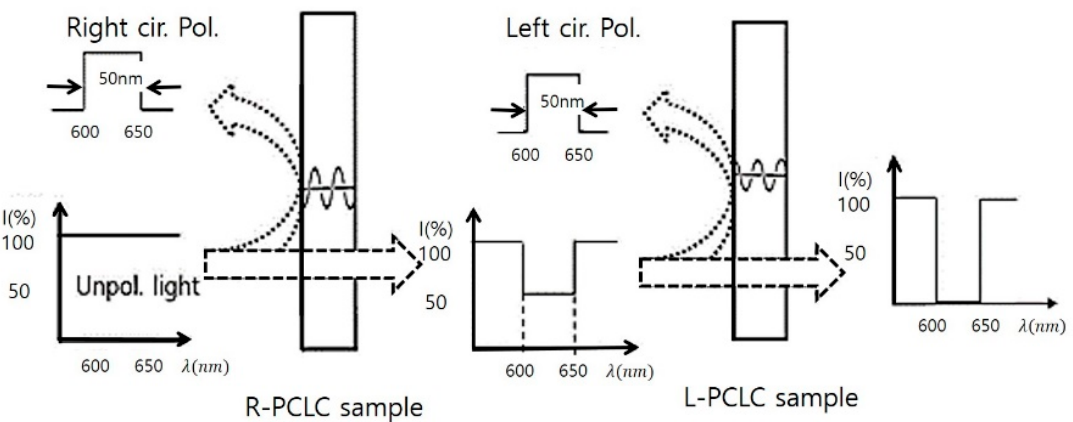
Figure 1. Principle of a circular polarizer by one R-PCLC (or L-PCLC) and a notch filter by two R- PCLCs. A notch filter works for unpolarized incident light, right-circularly polarized light in a photonic band is reflected at the R-PCLC cell, and then left-circularly polarized light in the same photonic band is reflected at the L-PCLC cell, in turn.